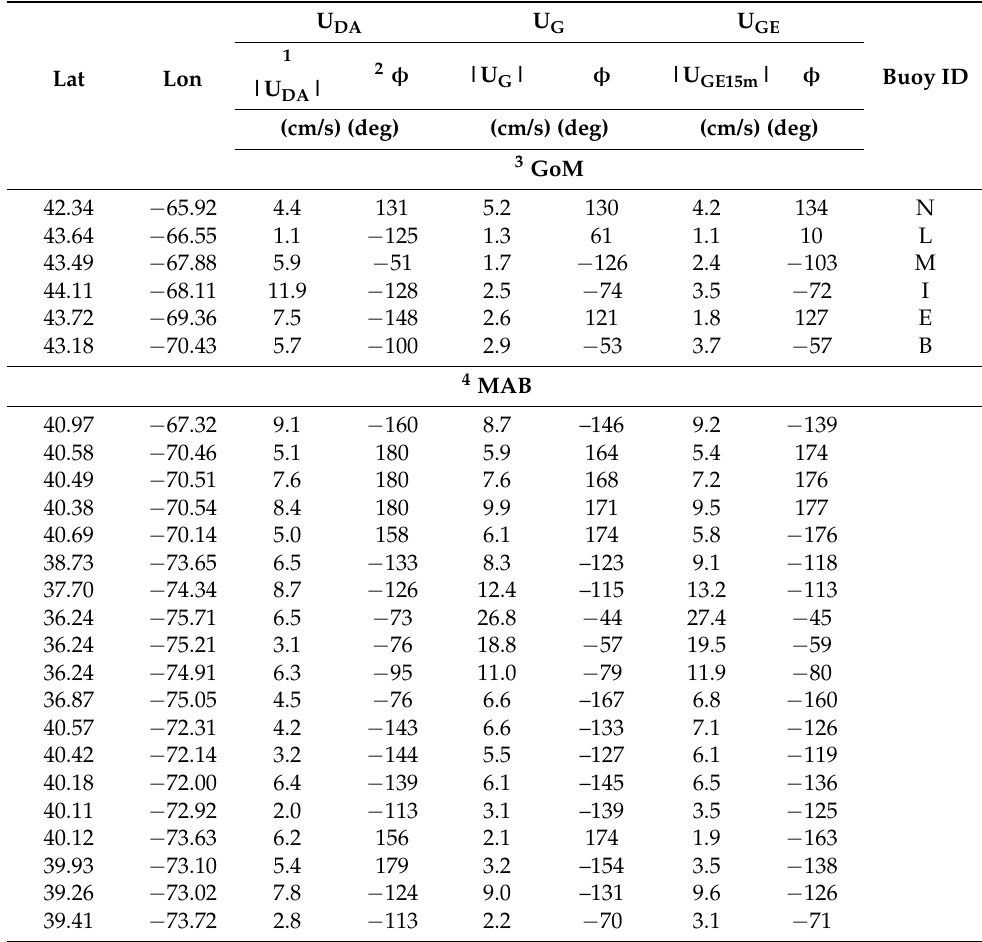
Table 1. Summary of mean current speed and direction measurements at the specified in situ current meter locations (Figure 1). In situ data are depth-averaged mean current vectors U DA while GlobCurrent data products U G (Geostrophic only) and U GE15m (Geostrophic and 15 m Ekman) are the prescribed upper ocean (15 m) current